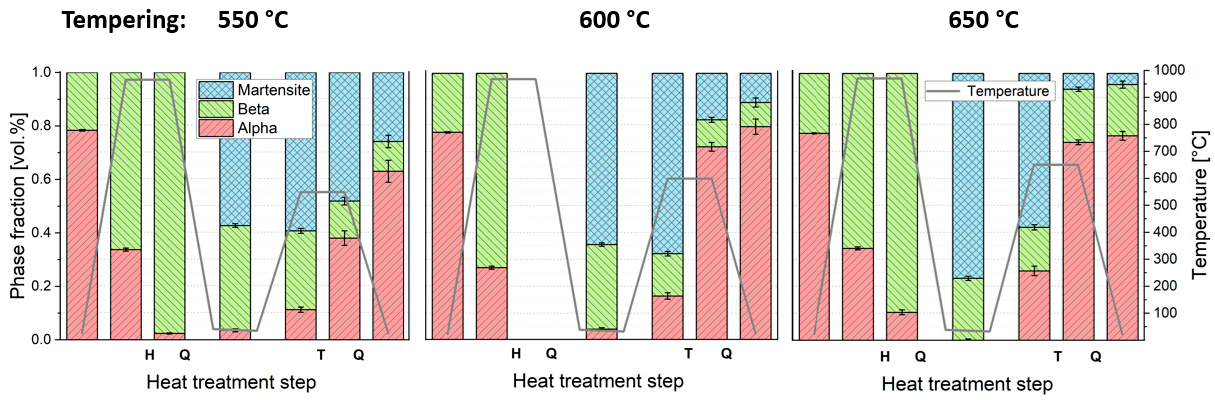
Figure 6. Overview graphs of the averaged phase fractions for the individual R.T. and high-temperature holding stages and the corresponding temperature profiles vs. heat treatment step.